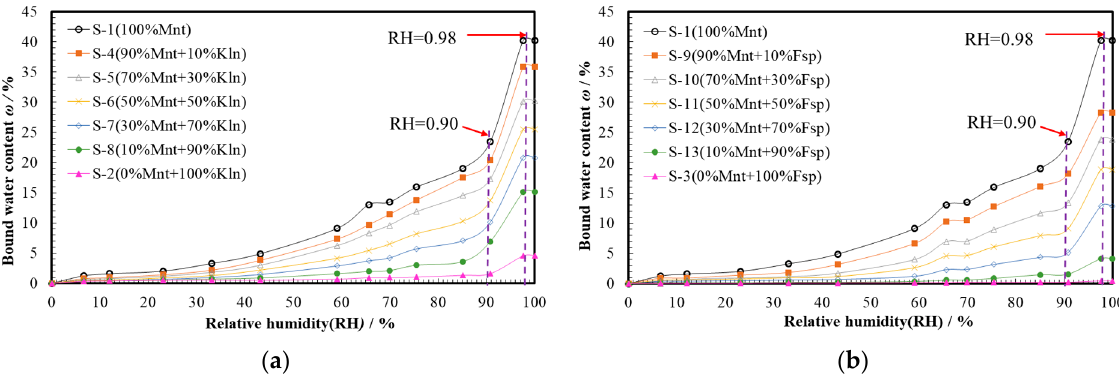
Figure 3. Relationship between SSA and C Mnt. of soils.